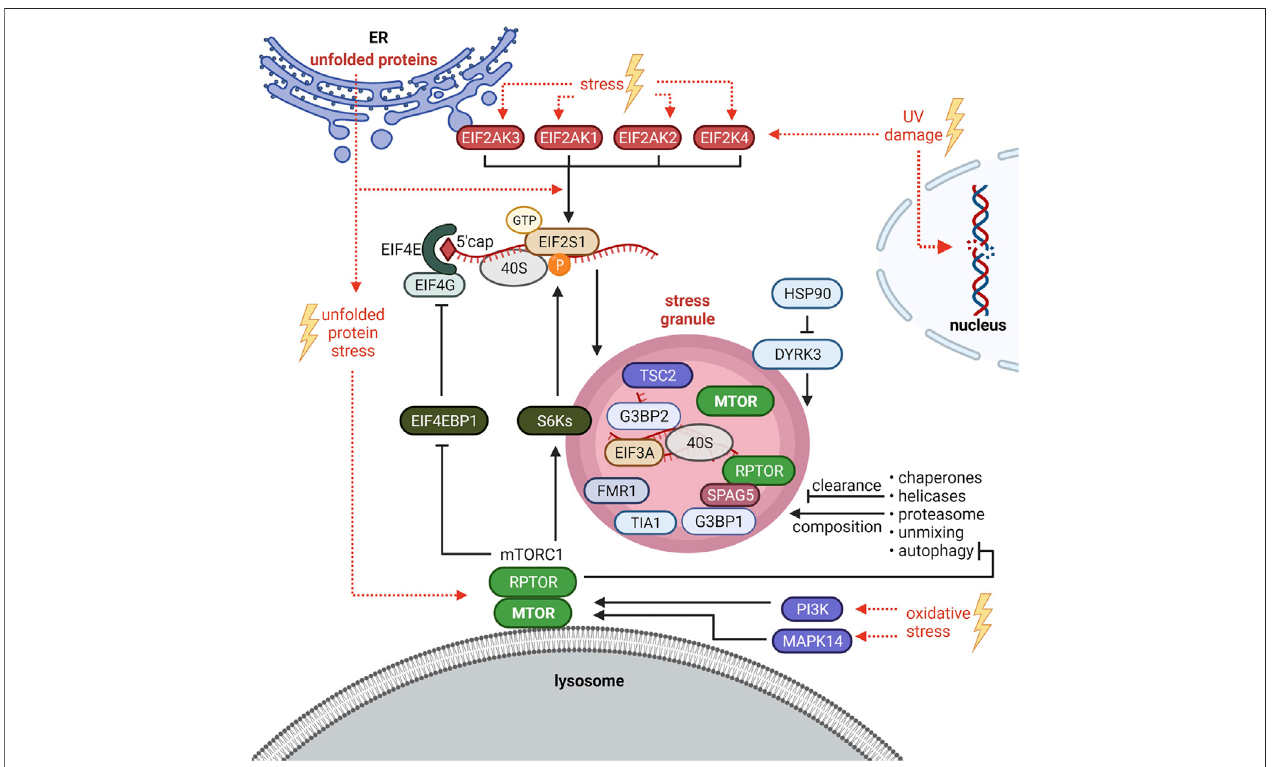
FIGURE2| Crosstalkbetweenstressgranules(SGs)andmTORC1signaling.SGformationistriggeredbyEIF2S1phosphorylationatserine51oratthelevelofthe EIF4Fcomplex.HRI/EIF2AK1,PKR/EIF2AK2, PERK/EIF2AK3 andGCN2/EIF2AK4phosphorylateEIF2S1-S51inresponsetodifferentstresses.Underoxidativestress, also the mTORC1-S6Ks axis enhances phosphorylation of EIF2S1-S51. Upon Bortezomib (unfolded protein stress), SGs are induced by mTORC1-driven phosphorylation of EIF4EBP1 to sustain EIF4F complex assembly. PI3K and MAPK14 activate mTORC1 to promote SG formation. Autophagy is inhibited by mTORC1 and mediates SG clearance and composition. SGs inhibit mTORC1 by sequestration of MTOR and RPTOR and via the HSP90-DYRK3 axis. SGs also recruit TSC2 and S6K1 and 2 (S6Ks). See main text for details and abbreviations.